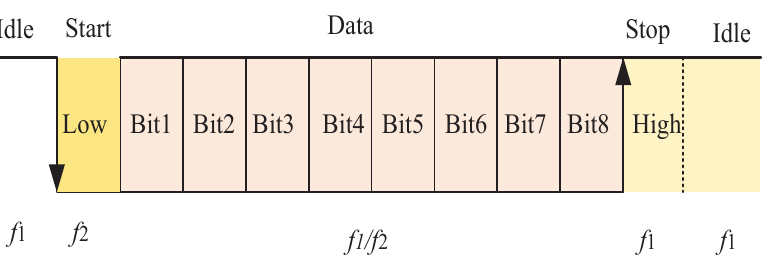
Figure 3. Schematic diagram of